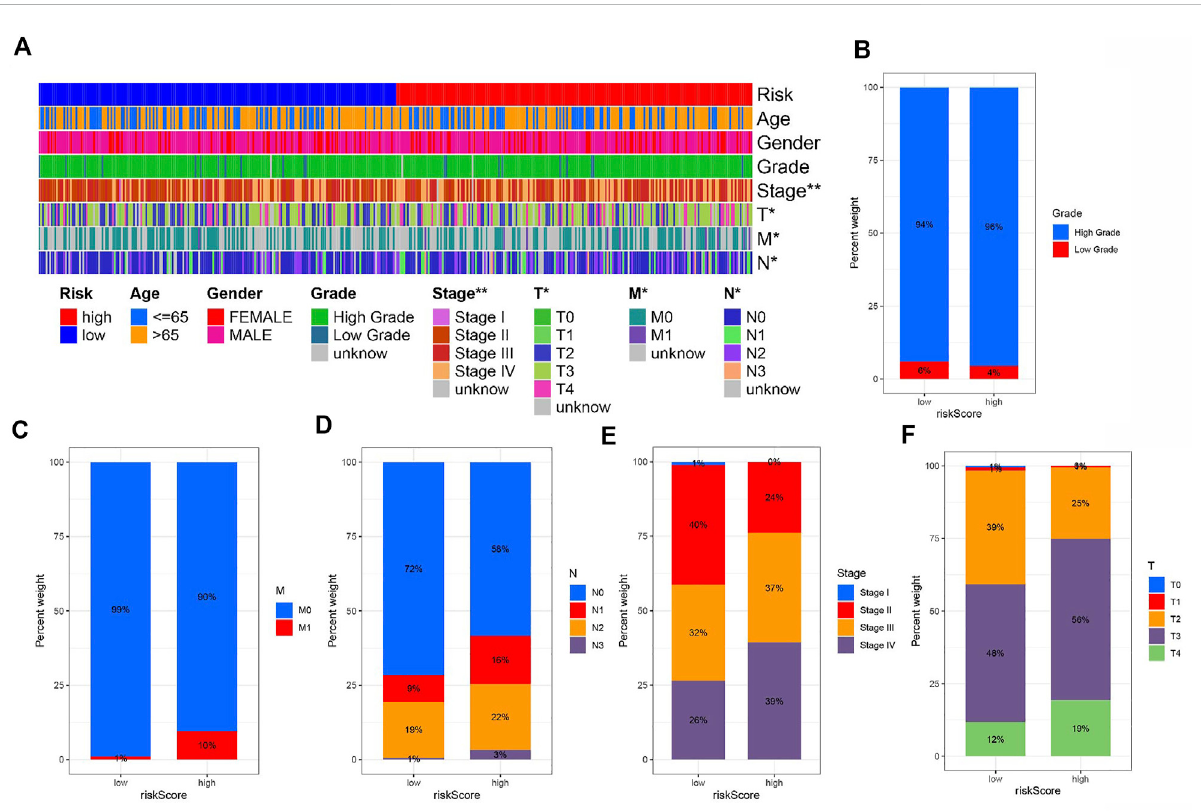
22 TICs in 407 samples are shown in Figure 1A. Supplementary Figure S1A depicts the relationship between the 22 TICs and the clinical phenotype. The potential connections between TICs and the associated relationships are further elucidated in Figure 1B.